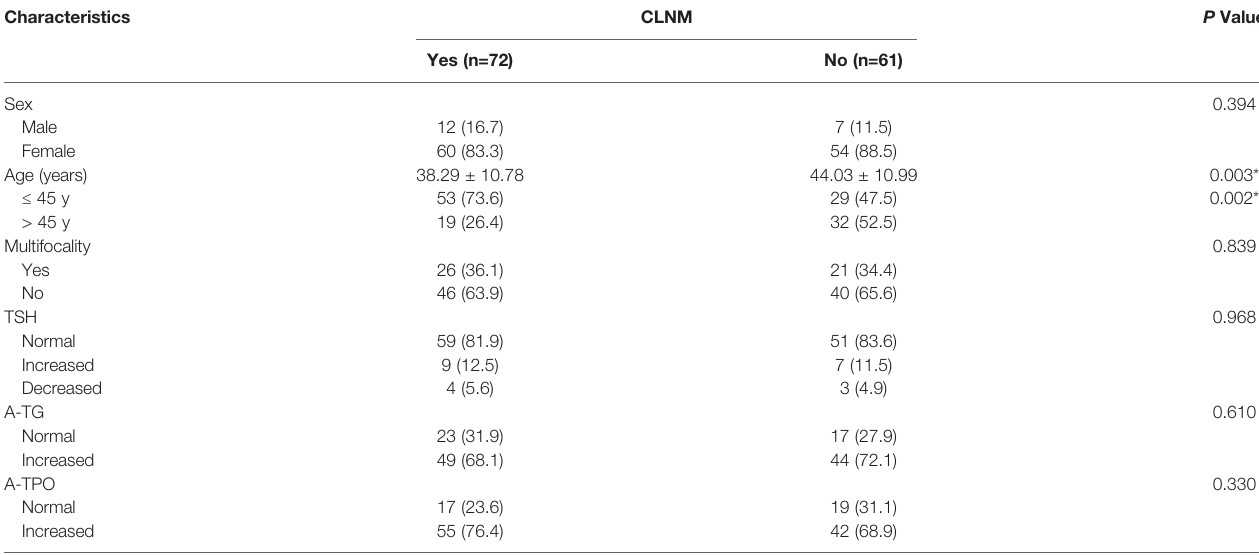
TABLE 1 | Clinical characteristics of PTC patients with Hashimoto ’ s thyroiditis based on CLNM.